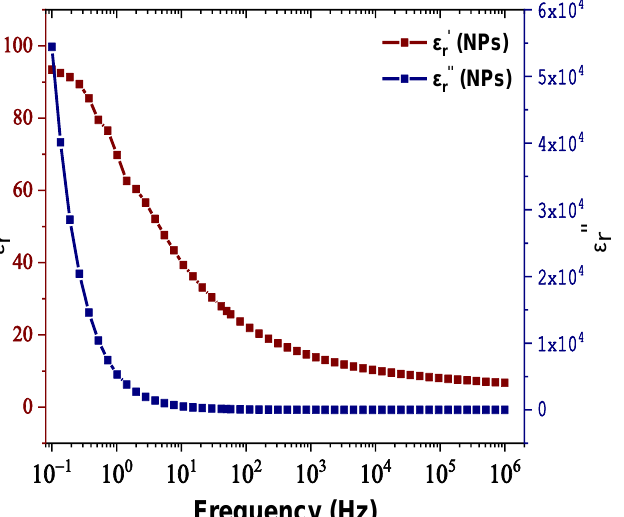
Figure 3. Change in the real and imaginary parts of relative permittivity versus frequency for the SiC nanoparticles.